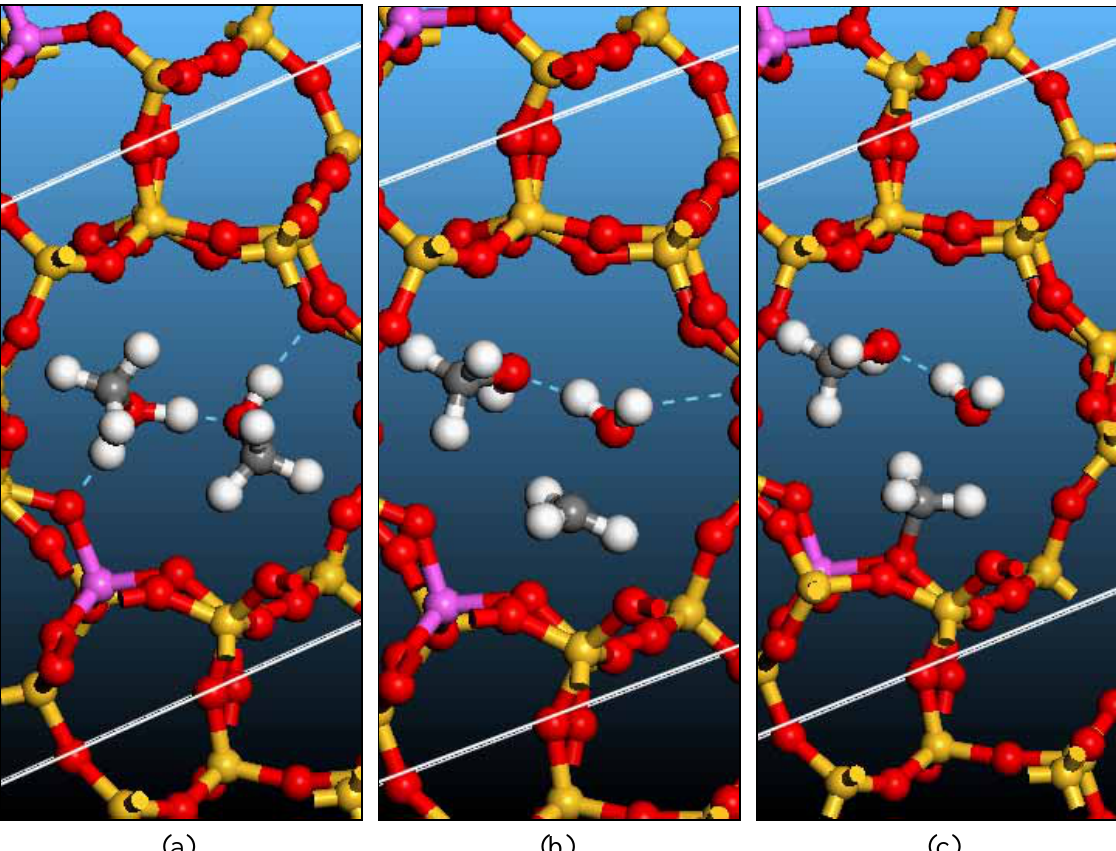
Figure 3. Surface methoxyl formation with two methanol molecules via a collinear S (a) Hydrogen bonded methanol and methoxonium ion complex, (b) Transition state structure, (c) Surface methoxyl. Dotted lines represent hydrogen